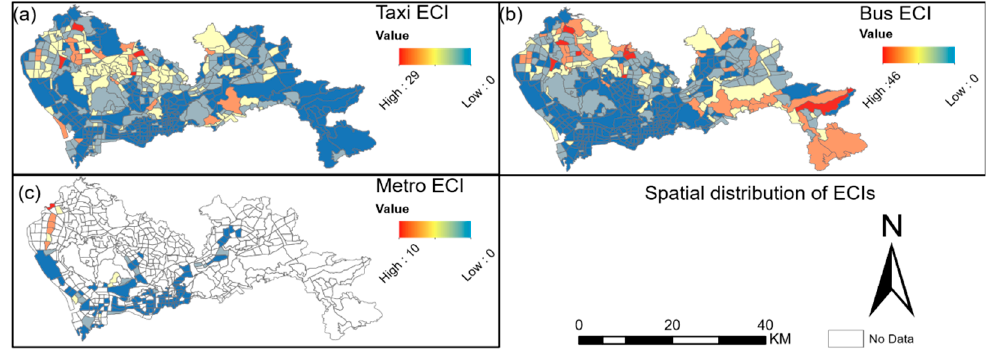
Figure 7. Spatial distribution of elasticity change index (ECI) for three transit modes. ( a ) ECI of taxi; ( b ) ECI of bus; ( c ) ECI of metro.